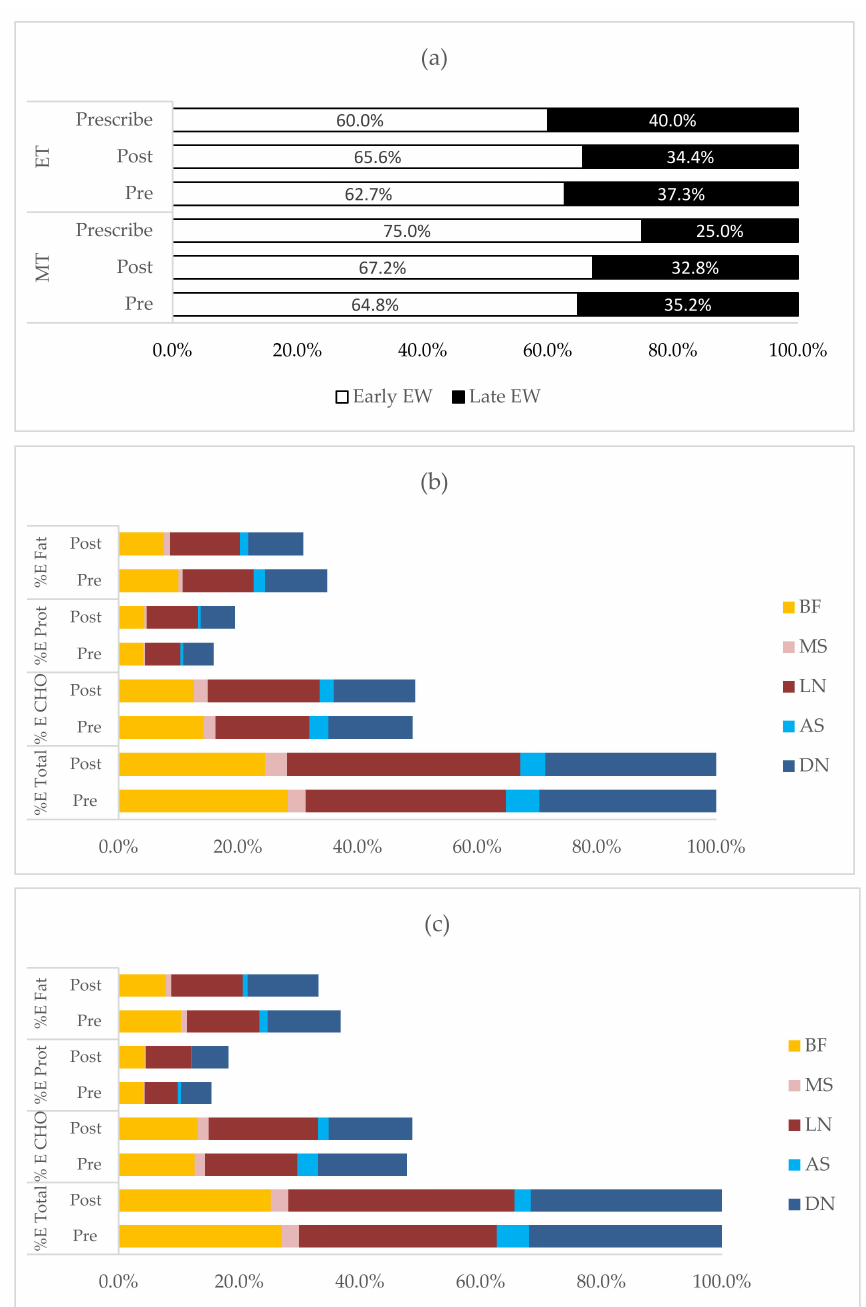
Figure 2. Pre–post differences in temporal patterns of energy and macronutrient intake based on early and late window. ( a ) The distribution of % E intake during pre- and post-intervention according to morning and evening chronotypes. ( b ) The distribution of % E from CHO, protein and fat based on early (breakfast, morning snack and lunch) and late (afternoon snack and dinner) windows in MT. ( c ) The distribution of % E from CHO, protein and fat based on early (breakfast, morning snack and lunch) and late (afternoon snack and dinner) windows in ET. Detailed statistical values described in Supplementary Table S2a,b. Abbreviations: E, energy; CHO, carbohydrate; prot, protein; MT, morning chronotype; ET, evening chronotype; EW, eating window; % E, percentage energy; BF, breakfast; MS, morning snack; LN, lunch; AS, afternoon snack; DN,